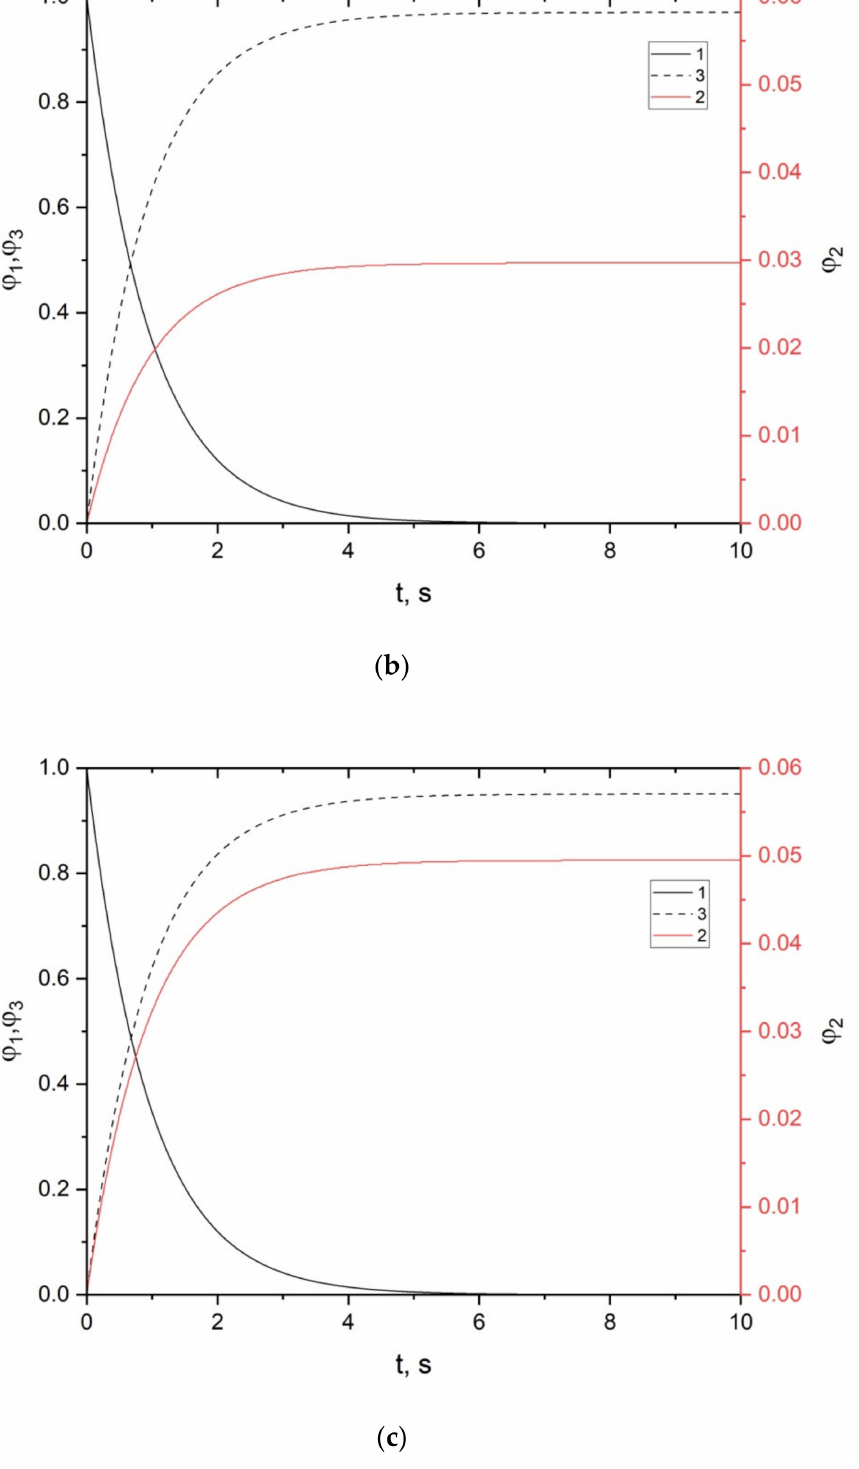
Figure 7. Dependences of volume fractions of phases on time for firebrand with a transverse dimension of 1 cm: 1: dry organic matter; 2: soot particles; 3: gas mixture; ( a ) dispersion coefficient 0.01; ( b ) dispersion coefficient 0.03; ( c ) dispersion coefficient